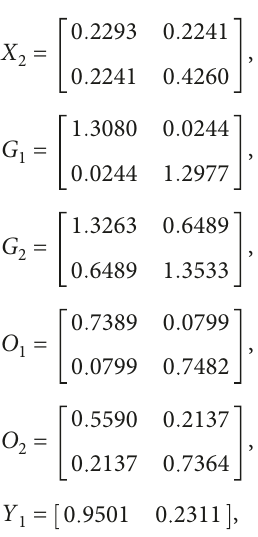
Figure 4: State response of the